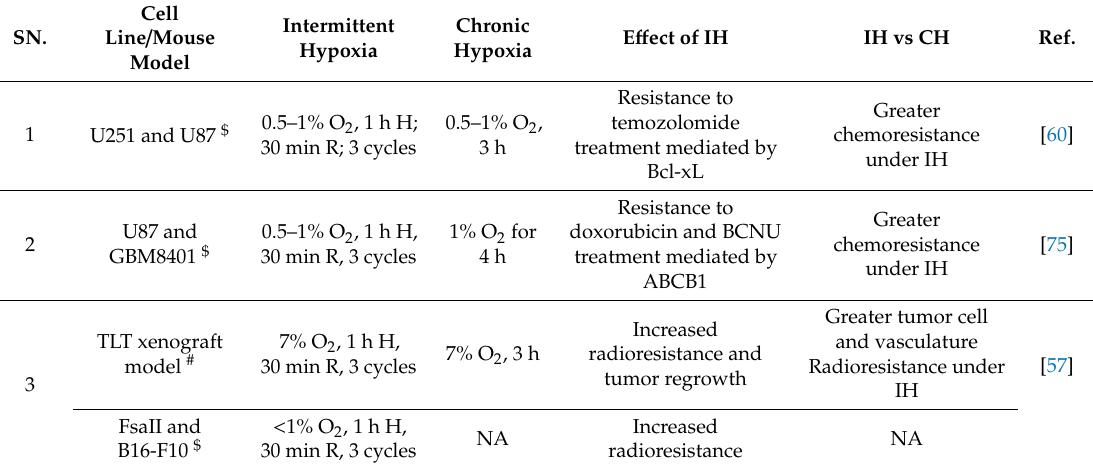
Table 5. E ff ect of IH on anti-cancer